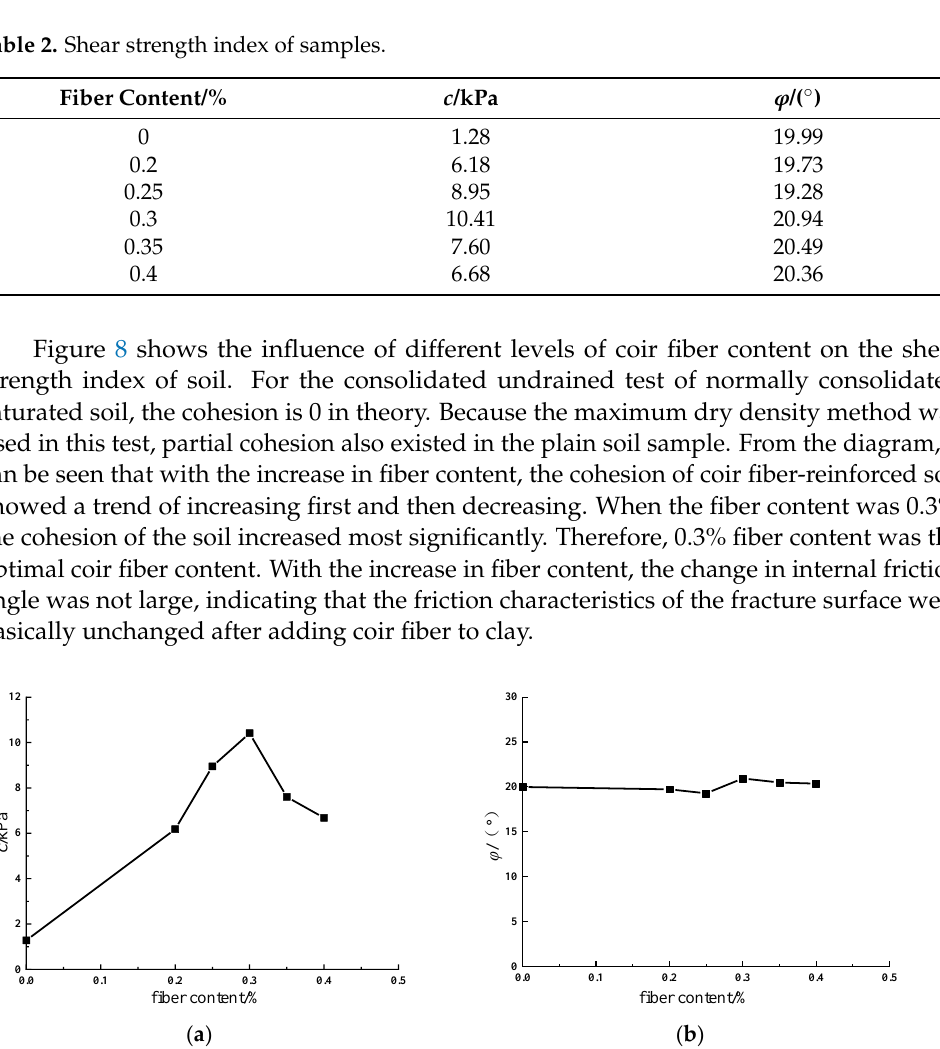
Figure 9. The failure mode of specimen under triaxial test. 4. Duncan – Chang Model and Parameter Analysis of Coir Fiber-Reinforced Red Clay From Figure 5, it can be seen that the stress – strain relationship curve of coir fiber- reinforced red clay is a typical strain hardening type, which conforms to the hyperbolic hypothesis of the Duncan – Chang model of a nonlinear elastic model. The Duncan – Chang model is widely used in numerical simulation and engineering practice and has great re- search value. Therefore, this paper used this model to fit the stress – strain relationship of coir fiber-reinforced red clay, and obtained the influence of fiber content and confining pressure on the parameters of the Duncan – Chang model. 4.1. Establishment of the Model In 1963, Kondner [44] proposed that the hyperbolic curve can be used to fit the curve according to the stress – strain relationship curve of a large number of soil triaxial tests. The hyperbolic equation is shown in Equation (1). Duncan et al. proposed a widely used